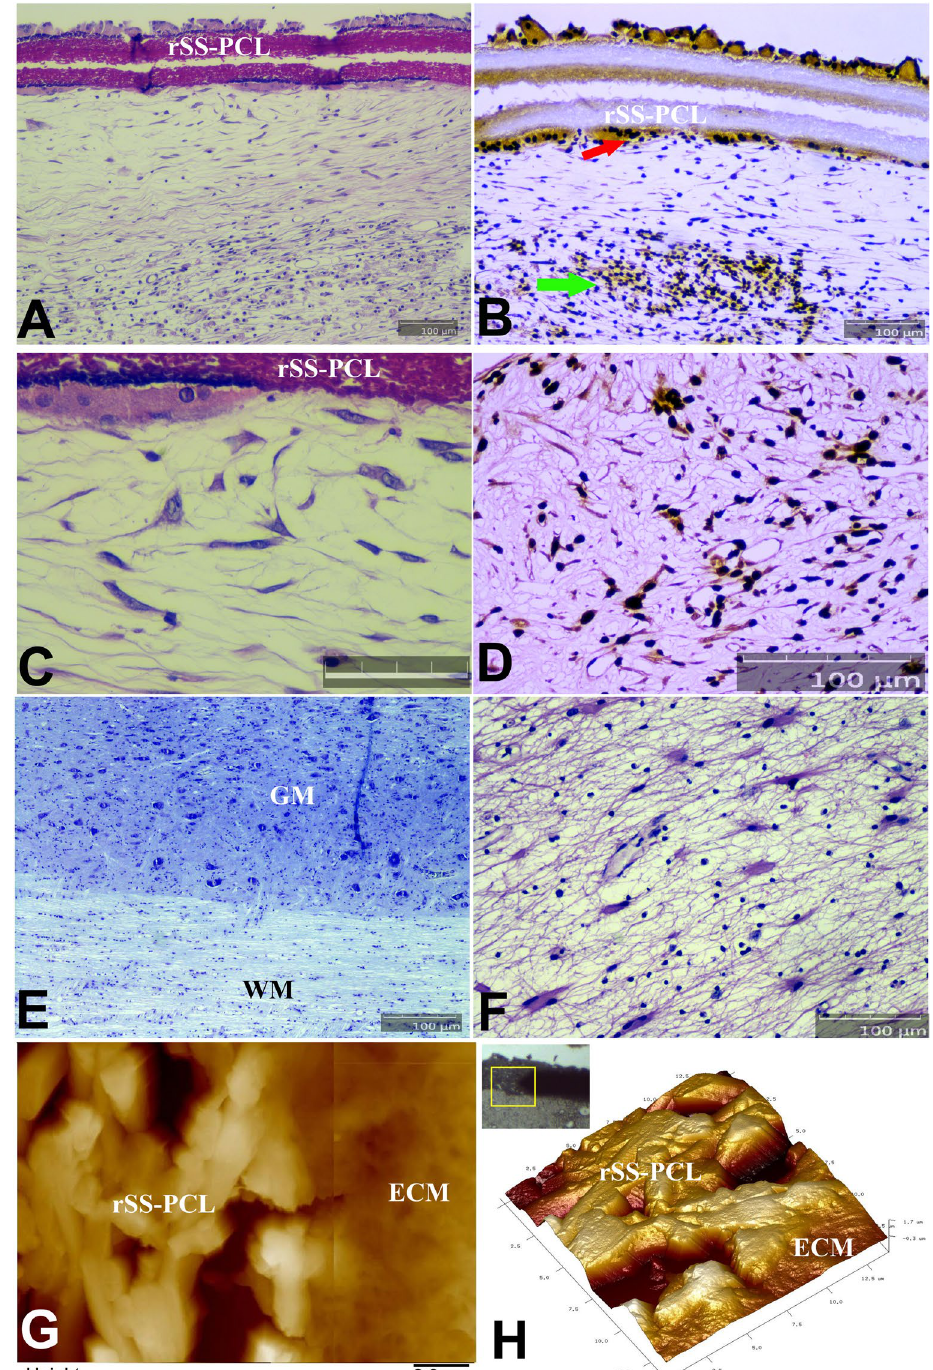
Figure 8. Histological and immunohistochemical (IHC) analysis of the SPRPix matrix with human drNPC implant with AFM imaging in the projection of the posterior column of the spinal cord of the rhesus macaque. ( A ) Sagittal section of the spinal cord stained with H&E. ( B ) Same spinal cord fragment, stained with antibodies to macro-H2A.1 visualized by immunoperoxidase staining. Transplanted cells highlighted by arrows. ( C ) Enlarged H&E image of ( A ) demonstrating the cells adjacent to the SPRPix matrix; Bar size = 50 µ m. ( D ) Same image as in ( C ), stained with antibodies to MAP2. ( E , F ) Sagittal sections of the spinal cord directly below the SPRPix matrix, Nissl ( G ) and H&E ( H ), stains. ( G , H ) 2D AFM image (overlay of two images from adjacent regions) and a 3D AFM image of the border between the SPRPix and the ECM of the surrounding tissue, showing full integration of the scaffold with the ECM. In panels ( A , B , D – F ) bar size = 100 µ m. Notations: rSS- PCL-spidroin-polycaprolactone scaffold; GM – grey matter; WM – white matter; ECM – extracellular